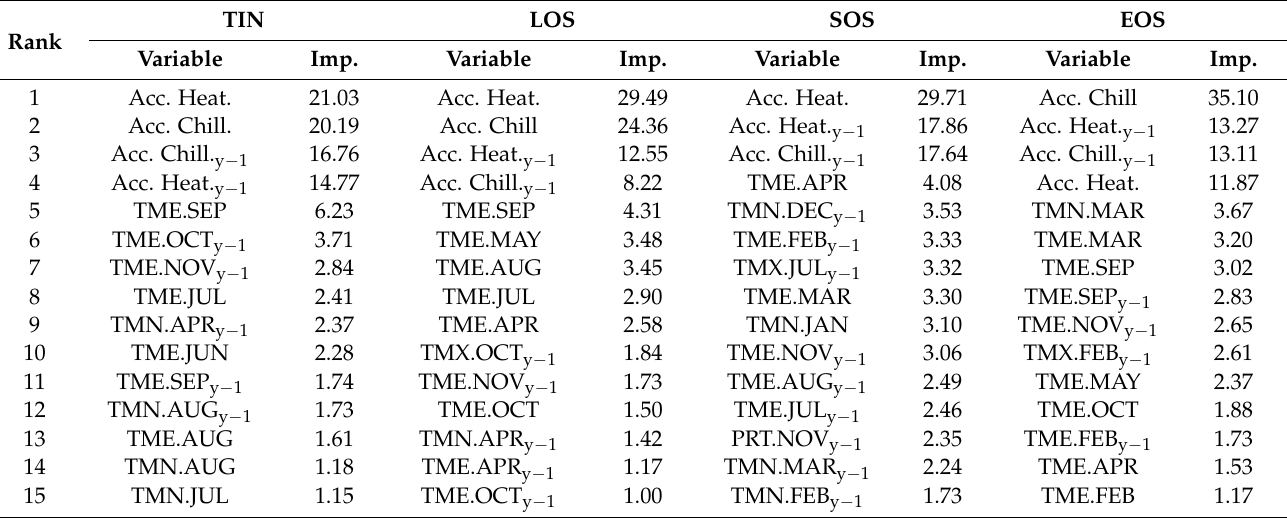
Table 4. Importance of climatic variables for modelling inter-annual variation in forest growth variables, ranked by scaled IncNodePurity. Variable importance (shown in the Imp. column for each final RF model) was scaled to a percentage (%) for comparison between final RF (Random Forest) models. Monthly climatic variables are labelled with the corresponding month, and lagged variables (i.e., from the previous year) are denoted with ‘ y − 1 ’. Forest growth indices: TIN = Time- integrated NDVI; LOS = length of growing season; SOS = start of season date; EOS = end of season date. Climatic variables: TMX, TME, TMN = maximum, mean and minimum temperature; precipitation =